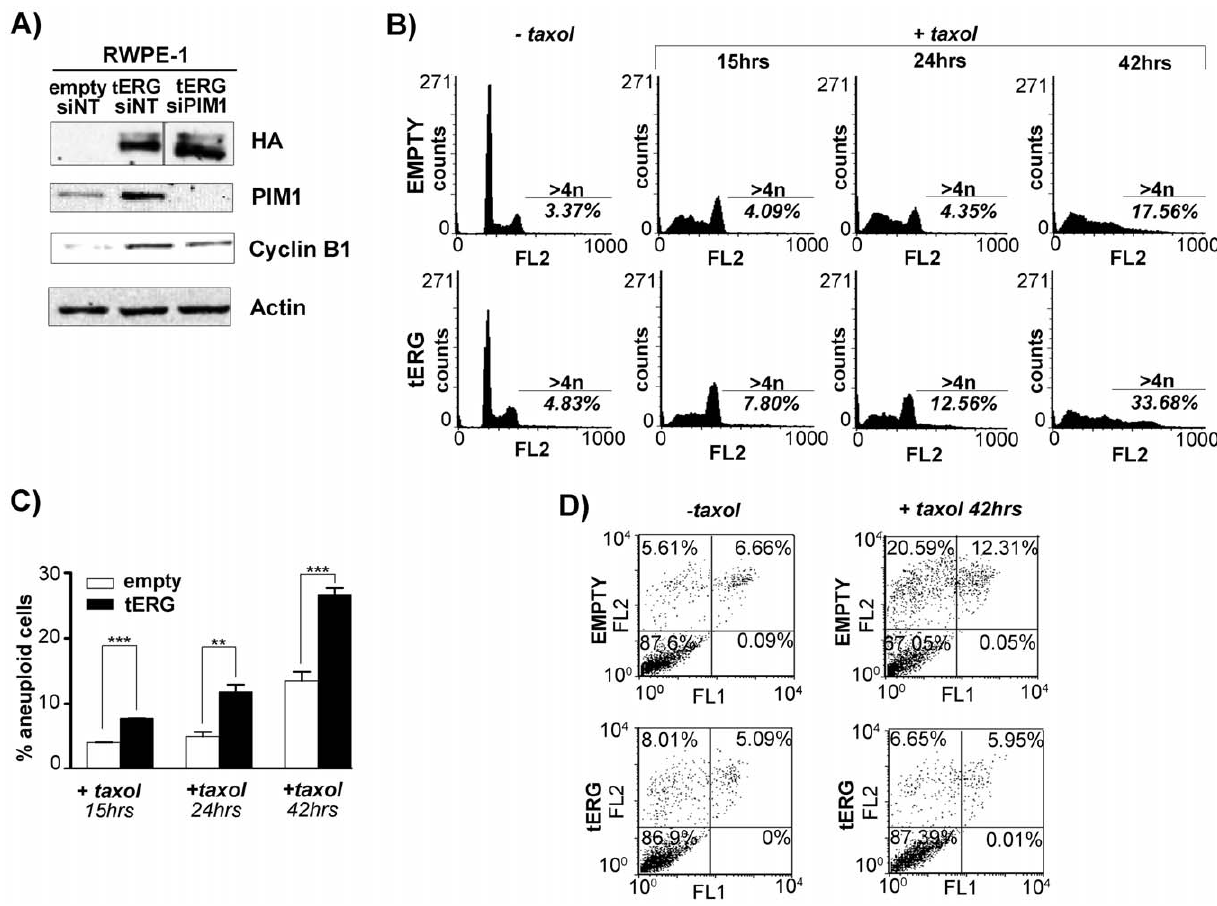
Figure 5. The tERG/PIM1 axis favours aneuploidy. a ) Immunoblot assay demonstrates Cyclin B1 increase in RWPE-1_tERG cells. siRNA knockdown of PIM1 (siPIM1) reduces this effect compared to non-targeting siRNA (siNT). The same amount of whole cell lysates were loaded in two different polyacrilamide gels. The tERG_siPIM1 sample for the HA immunoblot was loaded in a different position compared to the gel for PIM1, Actin and Cyclin B1 blot b ) Flow cytometric analysis of non-synchronized propidium iodide stained cells. Treatment with taxol for 15/24/42 hours induces an important increase in the . 4n fraction of RWPE-1_tERG compared to empty cells. c ) Percentage of . 4n cells after taxol treatment obtained from the average of at least two independent experiments. **=p , 0.01, ***=p , 0.001. d ) Annexin-V assay was carried out to evaluate apoptosis after 42 hrs of 10 nM taxol treatment for RWPE-1 transfectants. The percentage of cells in each quadrant is shown.